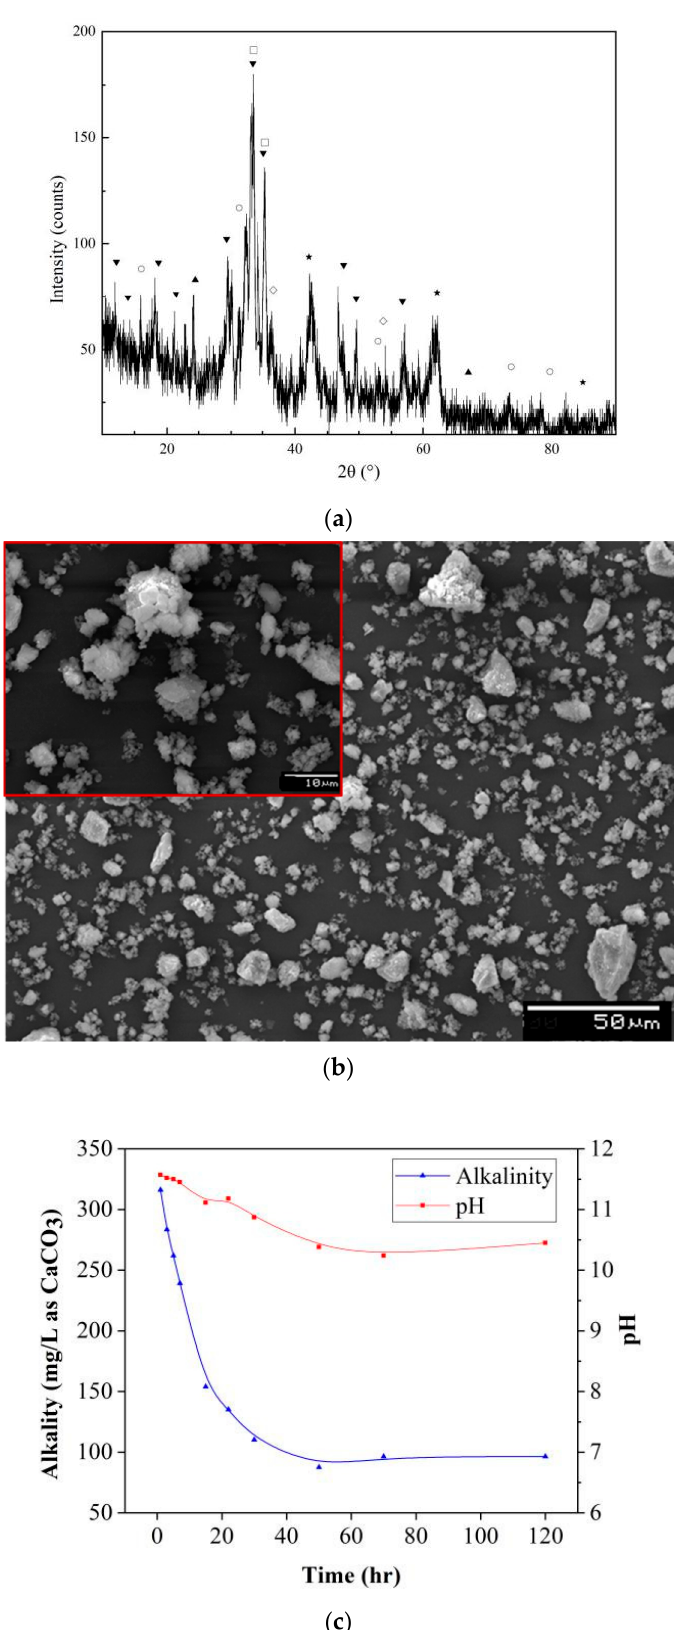
Figure 2. Characterization results of raw steel slag. ( a ) XRD patterns: ( ○ ) C 2 F, ( ▲ ) Mg-Al hy- drotalcite, ( ◊ ) f- CaO, ( ▼ ) C 2 S, ( ★ ) RO, ( □ ) C 3 S; ( b ) SEM image; ( c ) alkalinity production property.